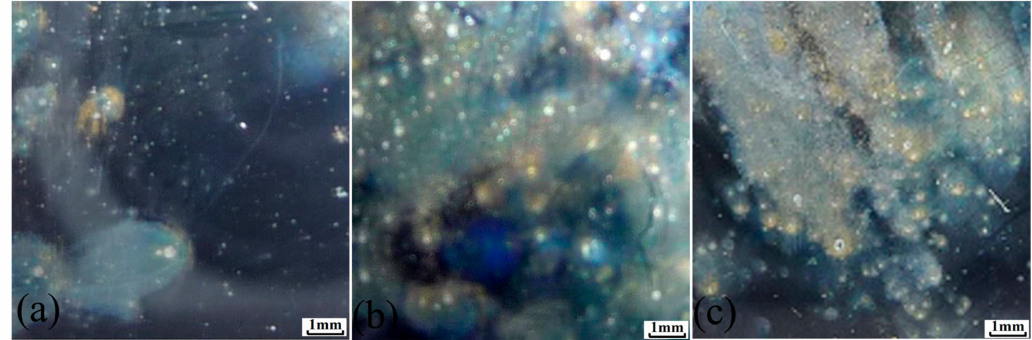
Figure 10. Corrosion macroscopic morphology of the X70 steel after immersion for 30 min in 0.1 mol/L NaCl solution at: ( a ) 0.1 MPa; ( b ) 5 MPa and ( c ) 10 MPa.